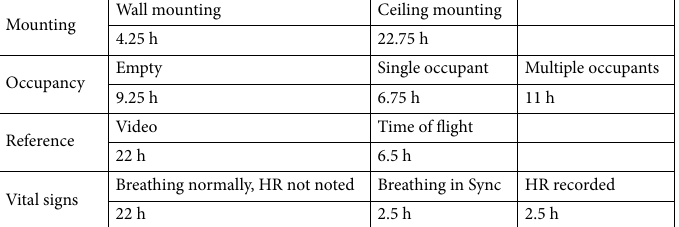
Table 1. Variables in Smart Conference Room data collection, with the amount of time each option was used rounded to the nearest quarter hour.